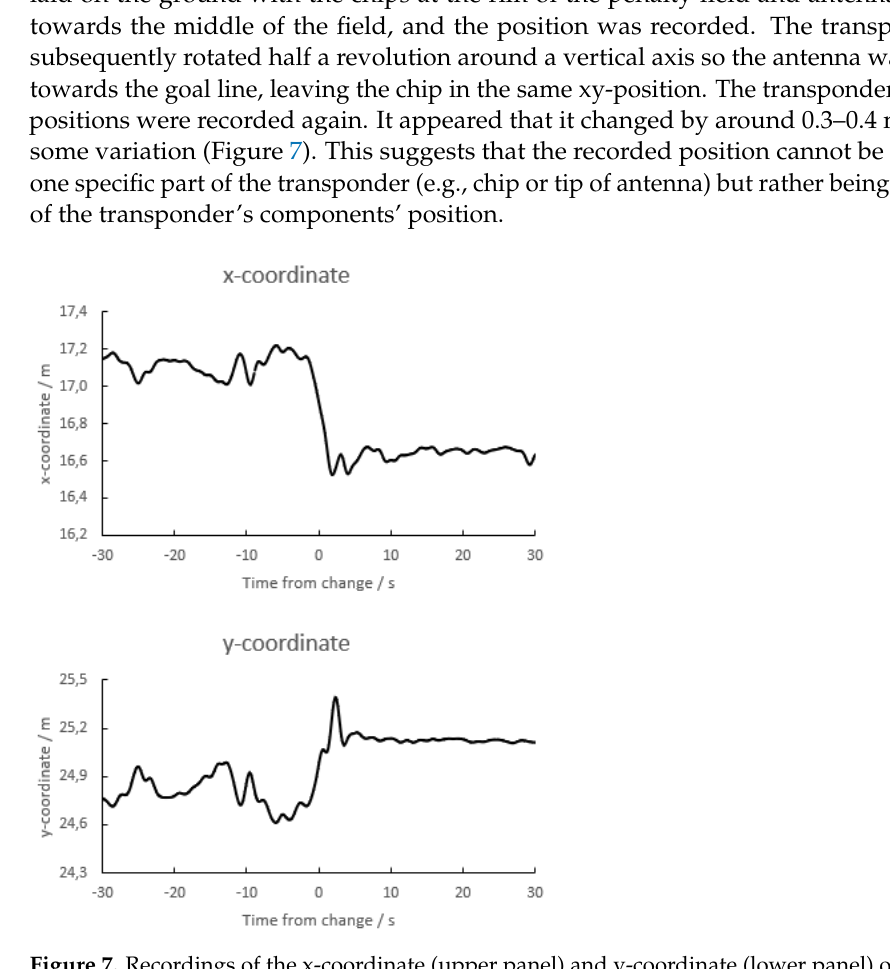
Figure 7. Recordings of the x-coordinate (upper panel) and y-coordinate (lower panel) of a transponder lying on the ground and being rotated half a revolution around the z-axis at time t = 0. During the rotation the x-coordinate of the antenna’s tip changed 60 cm while the chip was in the same position. There were no changes in the true y-coordinates. Note that the y-axes do not start at zero. In these experiments, the y-coordinate of the tip of the antenna of each transponder was not changed when the transponder was rotated a half revolution around the